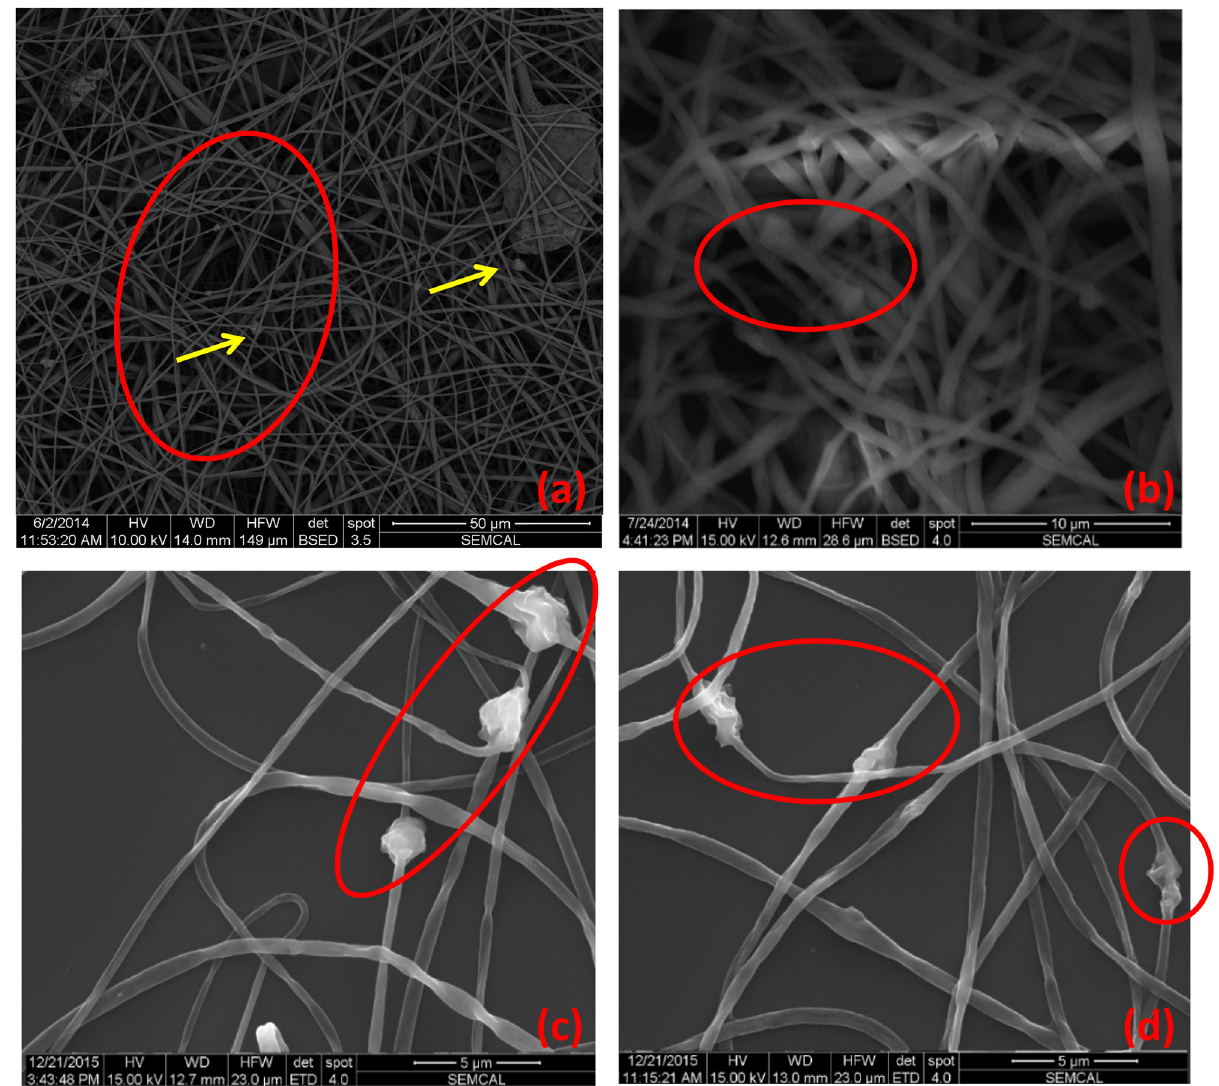
Figure 6: SEM images showing electrospun THV fi bers prepared from the THV/acetone solution with source clay standard Texas montmorillonite ( STx - 1b ) . ( a ) Sample 5 as listed in Tables 1 and 2 ( THV:montmorillonite/10:1 ) and sample 6 as listed in Tables 1 and 2. ( b ) ( THV:montmorillonite/5:1 ) prepared with 15 cm_16gauge_19 kV, SEM images taken by back - scattered electron detector ( BSED ) ; and sample 7 as listed in Tables 1 and 2. ( c ) ( THV:montmorillonite/10:1 ) , sample 8 as listed in Tables 1 and 2. ( d ) ( THV:montmorillonite/5:1 ) , prepared with 15 cm_22gauge_19 kV, SEM images taken by the Everhart – Thornley detector. ( a, c, and d ) Examples of clay in the fi bers. ( b ) Example of clay on fi bers indicated with the